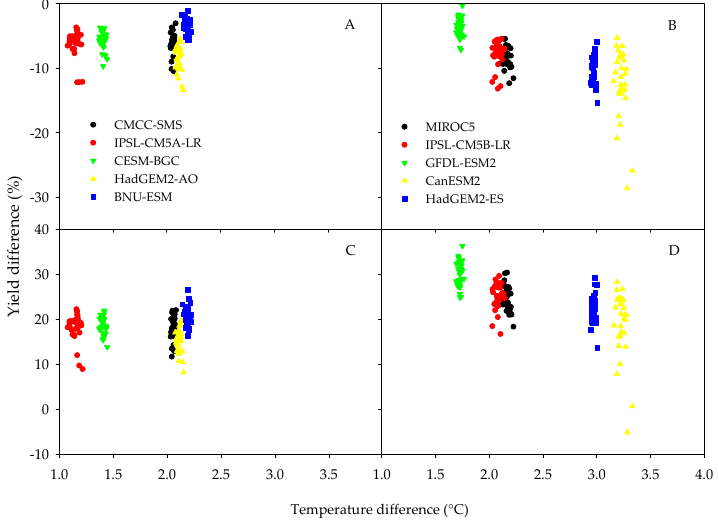
Figure 12. Relationship between average change in temperature over the growing season and the corresponding simulated change in grain yield under ( A ) RCP 4.5 with ambient CO 2 , ( B ) RCP 8.5 with ambient CO 2 , ( C ) RCP 4.5 with elevated CO 2 , and ( D ) RCP 8.5 with elevated atmospheric CO 2 for Tamale, Ghana.